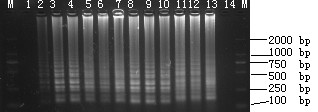
Sensitivities of LAMP for detection of plasmid pVP3. Lane M: DL-2000 marker; 1--12, reaction carried out using 10-fold serial dilutions of plasmid (pVP3) DNA (2.8 × 1011 copies/μl). 1: 2.8 × 100, 2: 2.8 × 101, 3: 2.8 × 102, 4: 2.8 × 103, 5: 2.8 × 104, 6: 2.8 × 105, 7: 2.8 × 106, 8: 2.8 × 107, 9: 2.8 × 108, 10: 2.8 × 109, 11: 2.8 × 1010, 12: 2.8 × 1011 copies/μl, respectively; lane 13:+, positive control; lane 14:-, negative control. All the products were electrophoresed on a 2% agarose gels and stained with ethidium bromide.